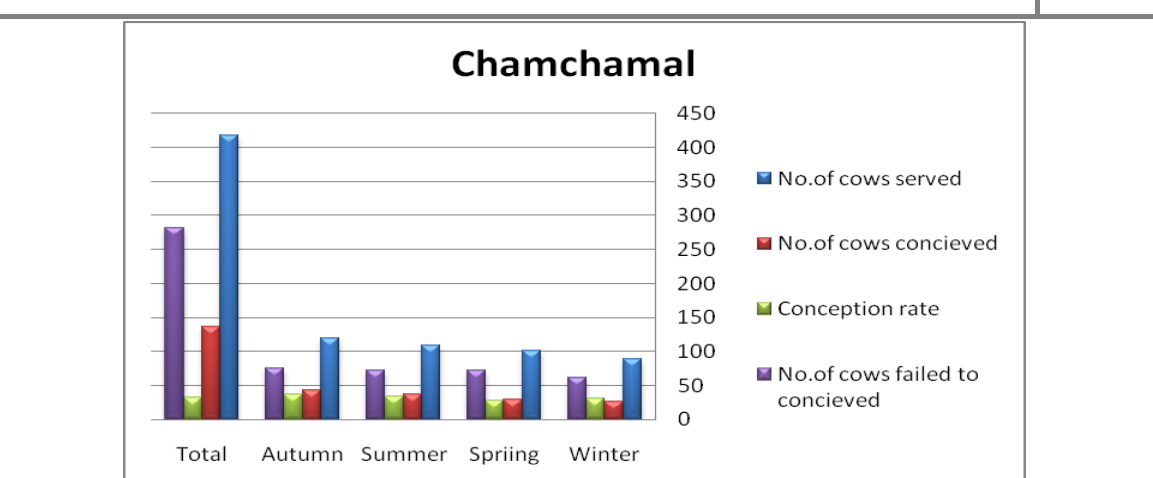
Figure, 5: Histogram the conception rate of cows and calf sex in different seasons for Chamchamal station. Table, 6: Number of inseminations per conception cows in four stations in Sulaimani regin. Total number of cows Number of cows Number of cows Number of cows conceived from conceived conceived from first conceived from third insemination insemination second insemination 493 342 (69.3%) 136 (27.5%) 15